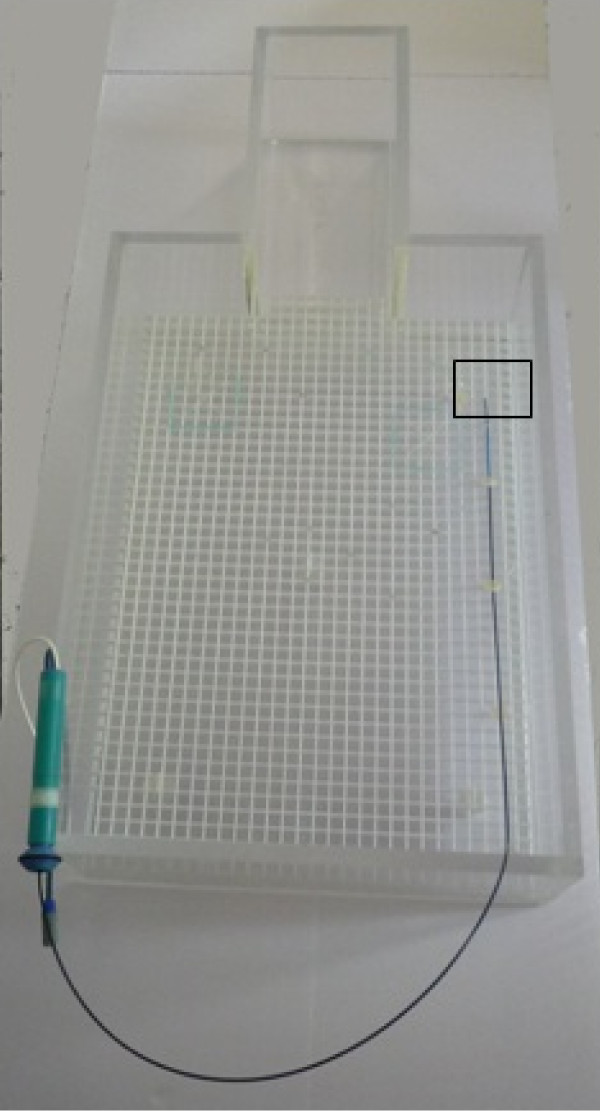
Catheter pathway in the MR scanner. The catheter is placed at the lateral left side of the phantom. The square indicates the location of the beef cube.